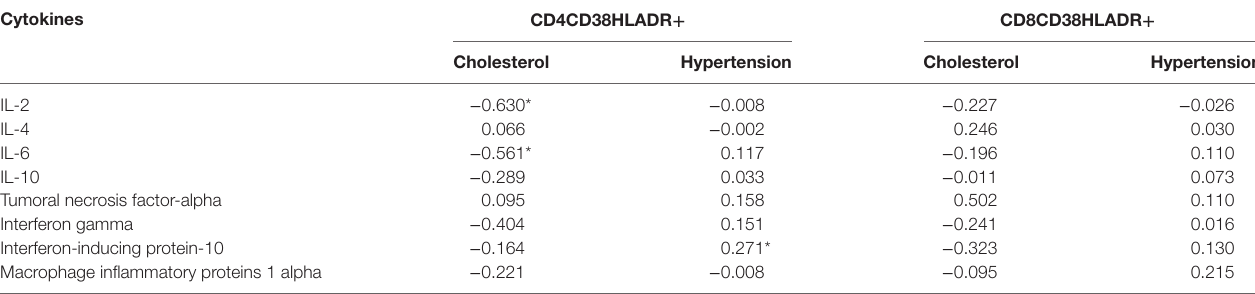
*p < 0.05 for the correlation between frequency of activated T cells and cytokines’ levels.